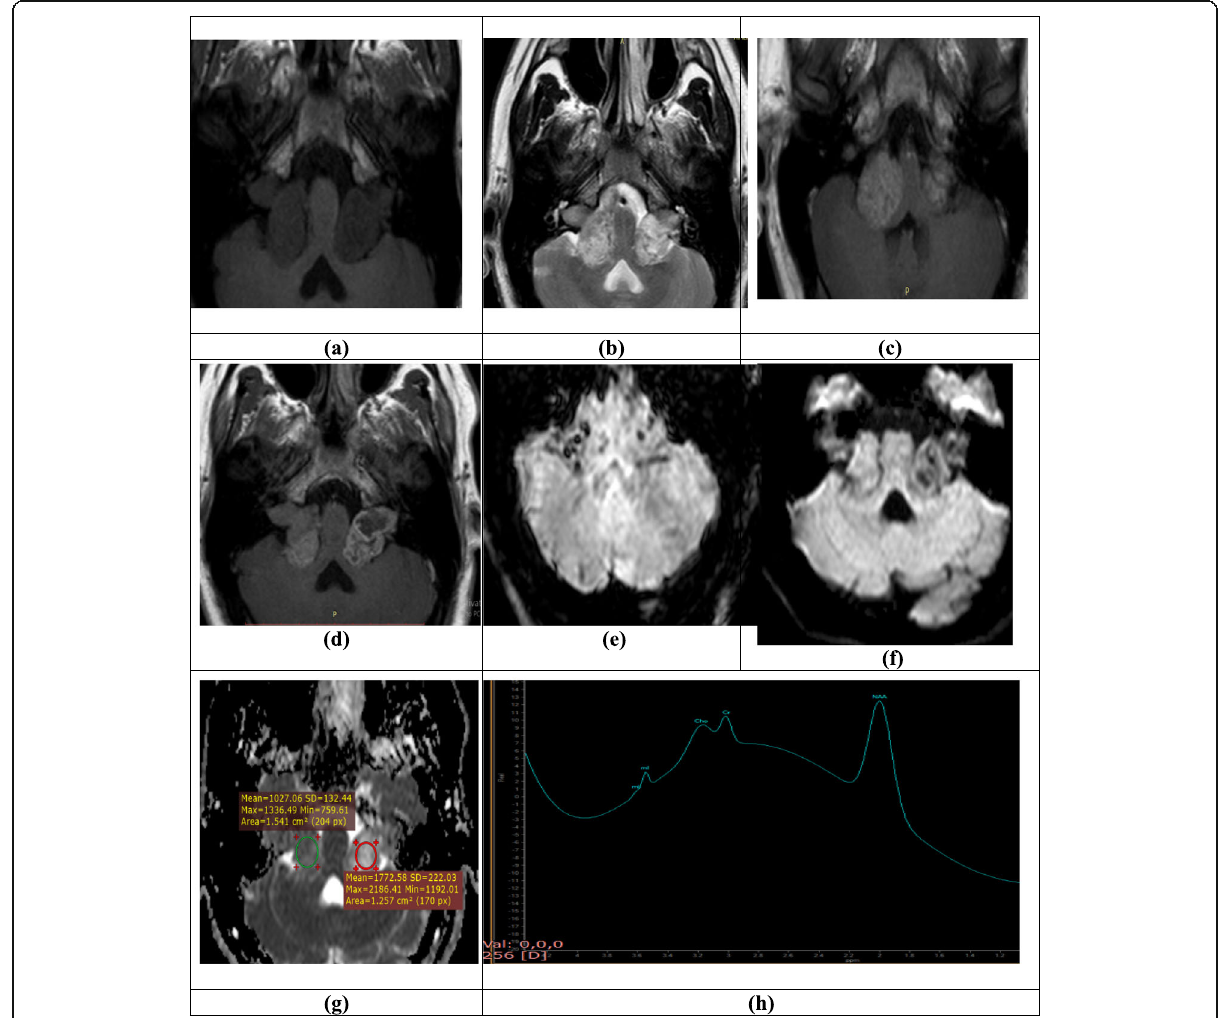
Fig. 3 A 21-years-old male patient with a known diagnosis of NF2 came for follow-up. Bilateral CPA space-occupying lesions are seen. They are hypointense on T1WI ( a ), hyperintense, extending into and widening the IACs on T2WI ( b ), showing heterogenous post-contrast enhancement on T1WI+C ( c , d ), showing signal voids of micro-bleeds on SWI ( e , f ). The right mass shows hyperintense signal in diffusion with ADC value =1.2 × 10 − 3 mm 2 . The left is hypointense on DWI with ADC value of 1.5 × 10 − 3 mm 2 ( g ). They showed myo-inositol peak on MRS. The findings were matching with the final diagnosis of NF2 with bilateral CPA